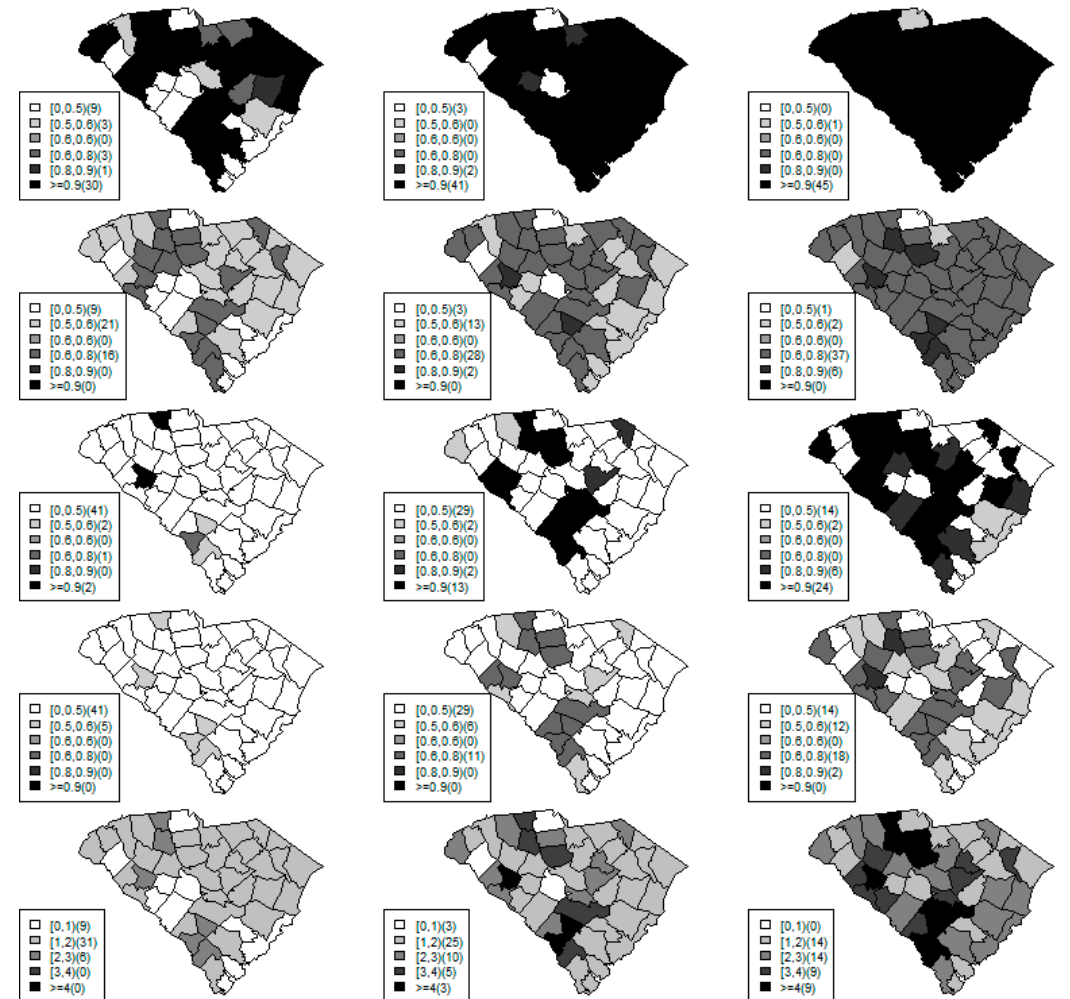
Figure 6. Maps of exceedence probability under mean regression for each area with cut-off points of 1 ( c = 1; first row) and 2 ( c = 2; third row). Maps of exceedance probability under quantile modeling with cut-off points of 1 ( c = 1; second row) and 2 ( c = 2; forth row) compared to the posterior estimated relative risk (fifth row) during weeks of 34 (left column), 35 (middle), and 36 (right column).